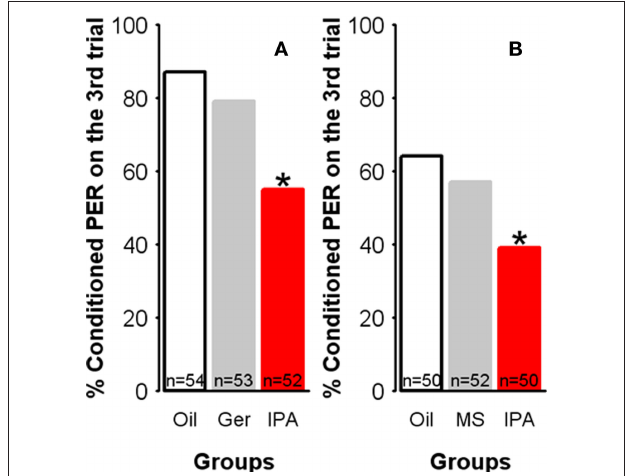
Figure 5 | Learning impairment is specific to iPA exposure. Learning performances, as indicated by the percentage of conditioned PER to the conditioned odor on the third trial (PER conditioning), for each group. (A) Compared with controls ( Oil ), learning remained unaffected after exposure to geraniol ( Ger ), a compound belonging to the attractive Nasonov pheromone or (B) to methyl salicylate ( MS ), a non-pheromonal ester. By contrast, bees exposed to IPA show significantly fewer conditioned responses. * p < 0.025 (as compared with respective control